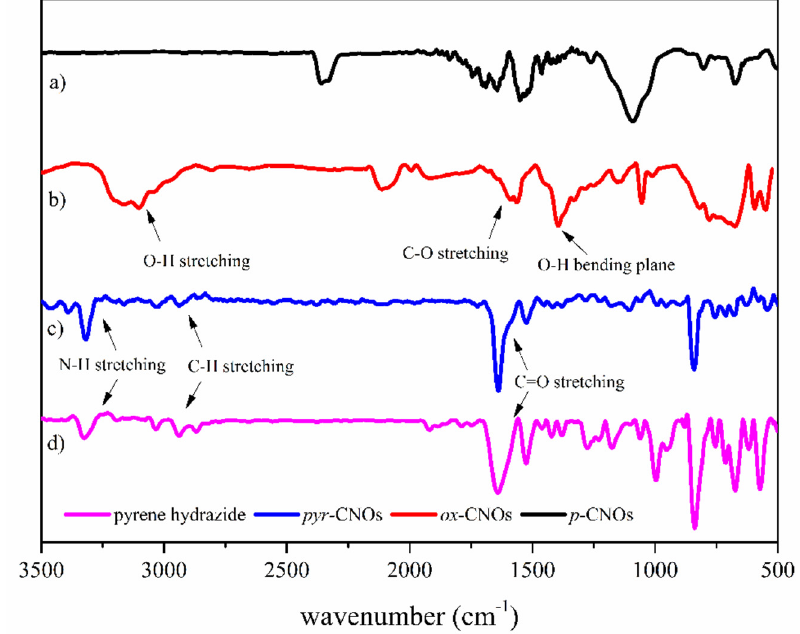
Figure 3. FT-IR spectra of ( a ) p -CNOs, ( b ) ox -CNOs, ( c ) pyr -CNOs, ( d ) pyrene hydrazide.